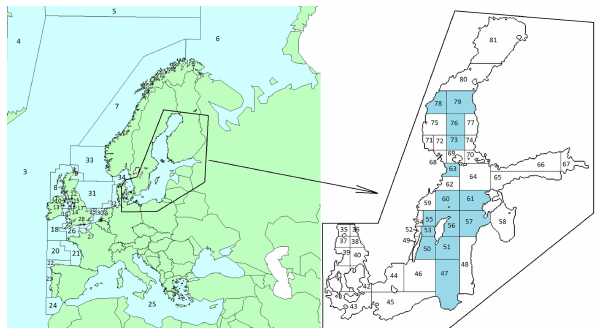
Figure 5. Compartment system of POSEIDON-R model for the north-eastern part of the Atlantic Ocean, the North Sea, and the Baltic Sea. The shaded boxes represent boxes with two vertical lay- ers. All other boxes in the Baltic Sea consist of one vertical layer in the